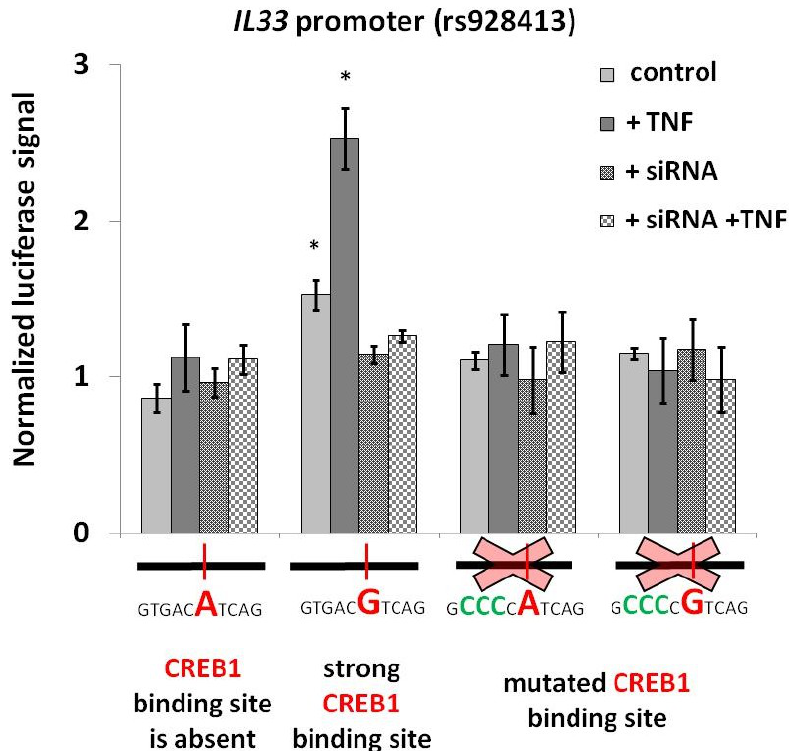
Figure 4. The rs928413(G) allele mediates CREB1-dependent IL33 promoter stimulation of lung cancer cells by TNF. Reporter constructs contained Firefly luciferase gene under the control of indicated versions of the IL33 promoter. siRNA for the CREB1 knockdown was electroporated 24 h prior to electroporation of the reporter. TNF (100 ng/mL) was added at the time of both electroporations. The data shown (mean ± SEM) was obtained in five independent experiments and normalized to Renilla luciferase activity. * p < 0.01.